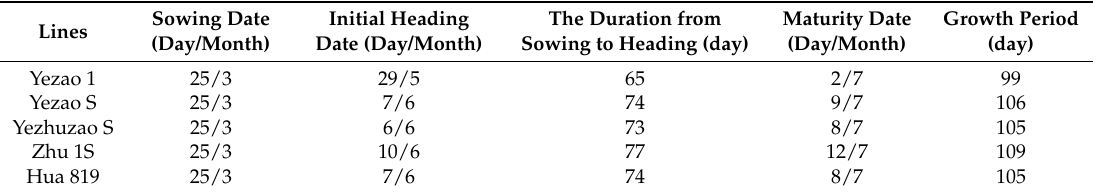
Table 2. Comparison of the growth period of different rice lines.